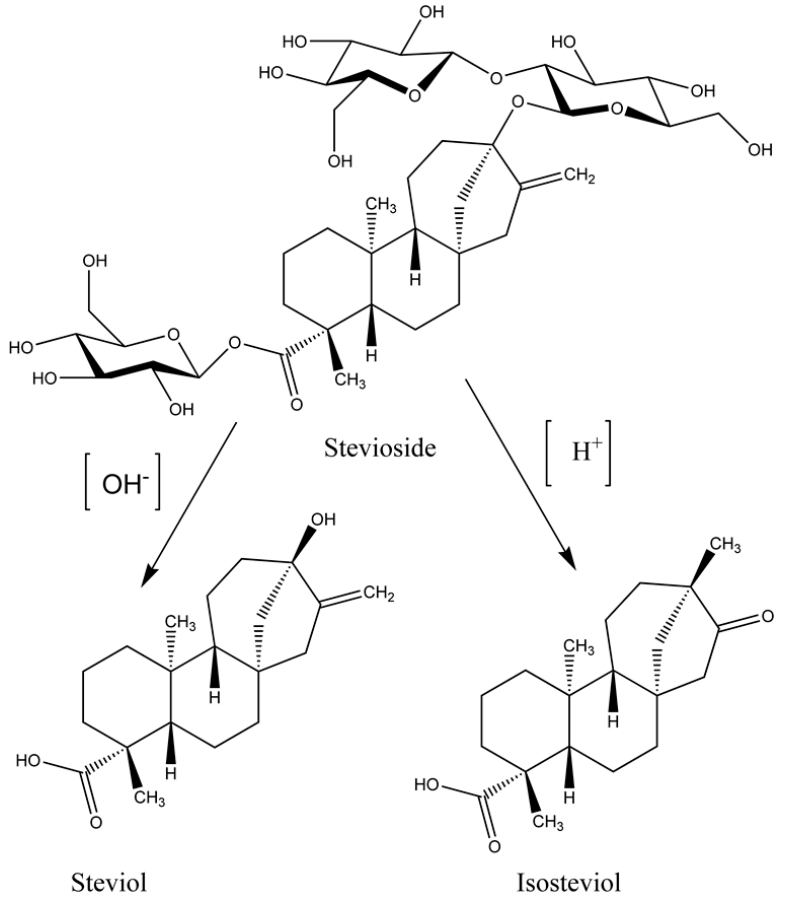
Figure 1. Formation of steviol and isosteviol from stevioside at different pH conditions.